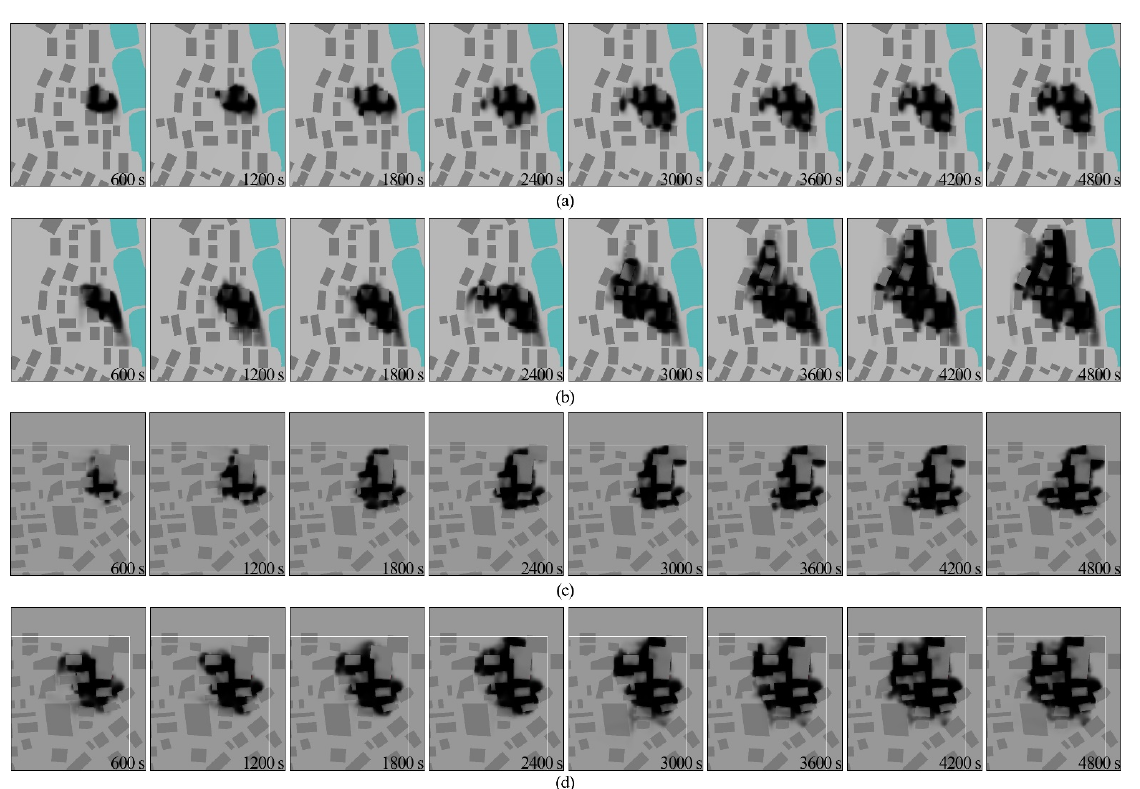
Figure A2. The moisture content of the ancient village houses’ wood. ( a ) High chair Village; ( b ) Pingtan village; and ( c ) Shuangfeng village.